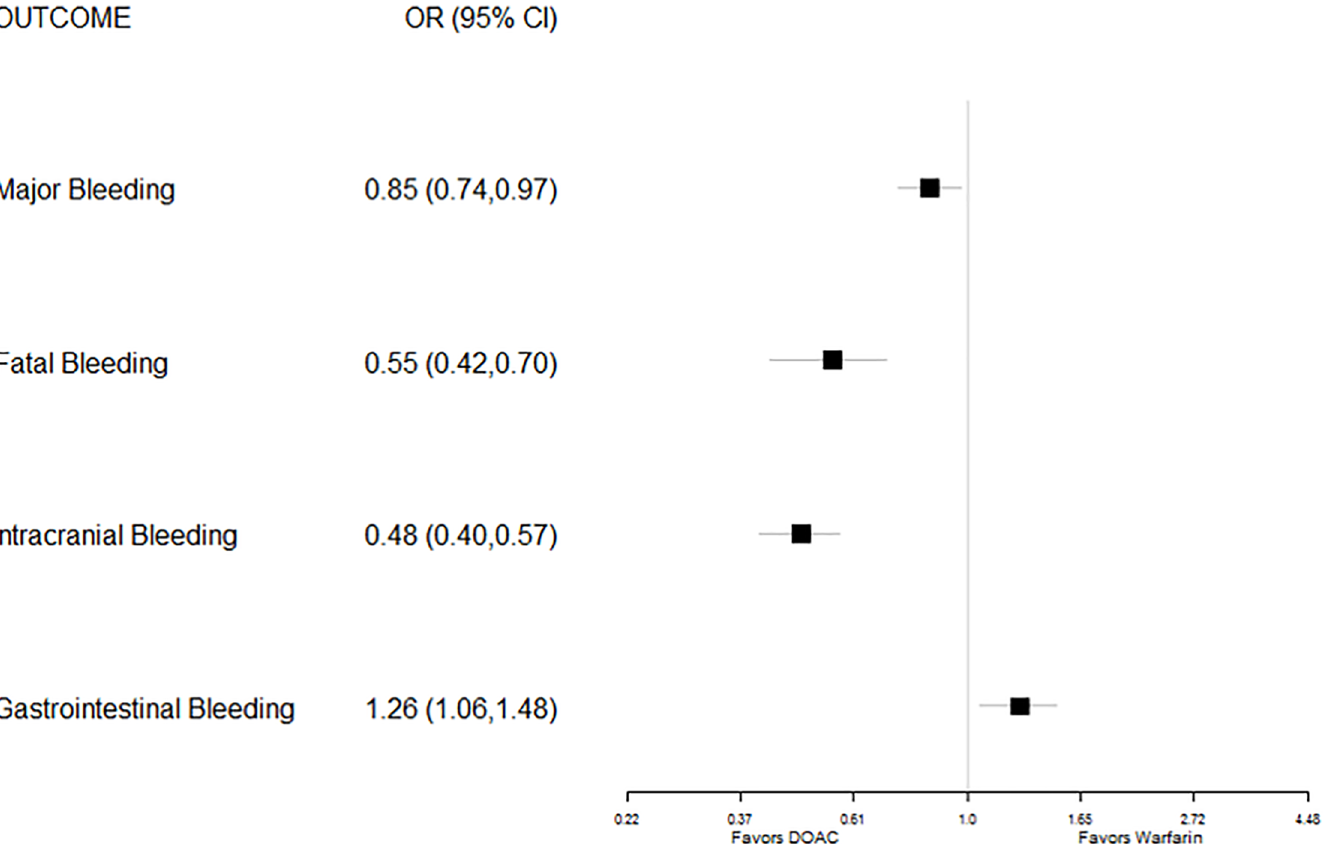
Fig 3. Forest plot of pooled odds ratios (with 95% CI) of various adverse drug events for FDA-approved direct oral anticoagulants versus warfarin for thromboembolic stroke prophylaxis in non-valvular atrial